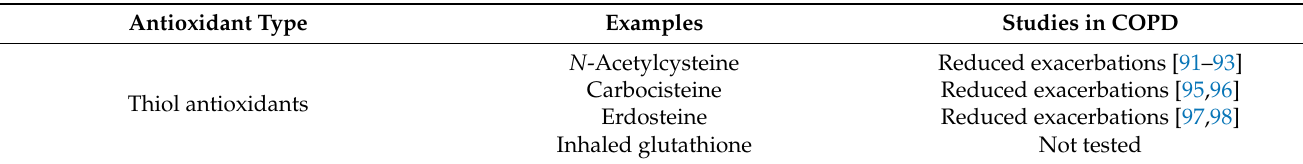
Table 1. Antioxidants for